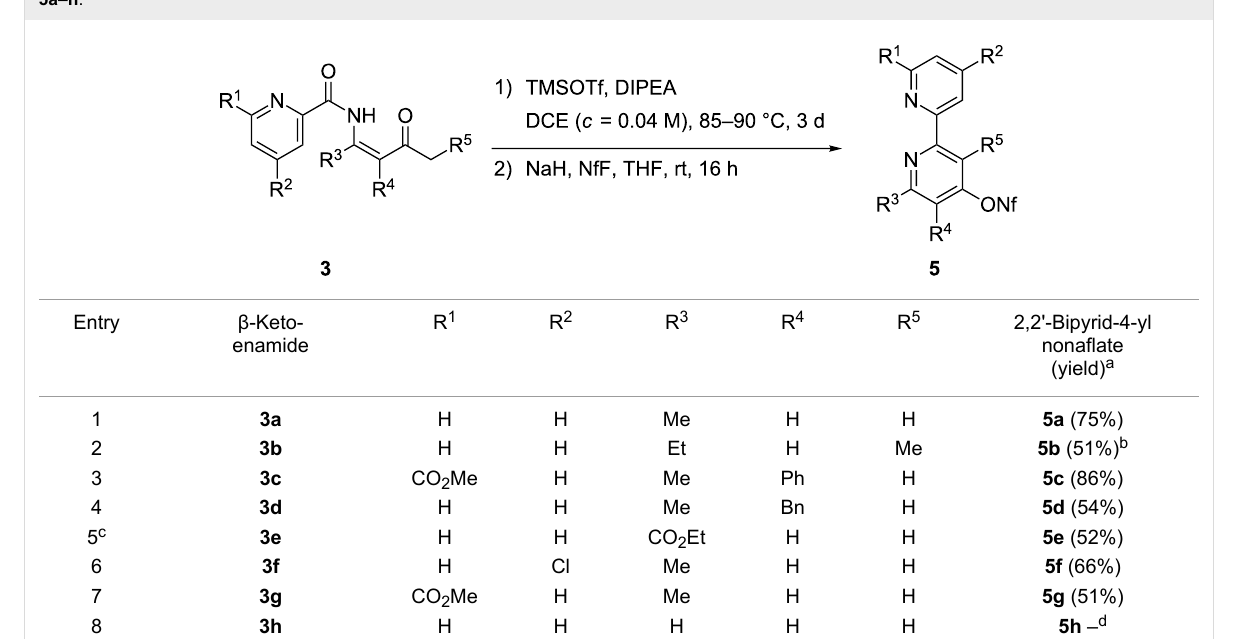
Table 1: Attempted TMSOTf/DIPEA-promoted cyclocondensations of β -ketoenamides 3a – h and subsequent O -nonaflation leading to 2,2'-bipyridines 5a – h